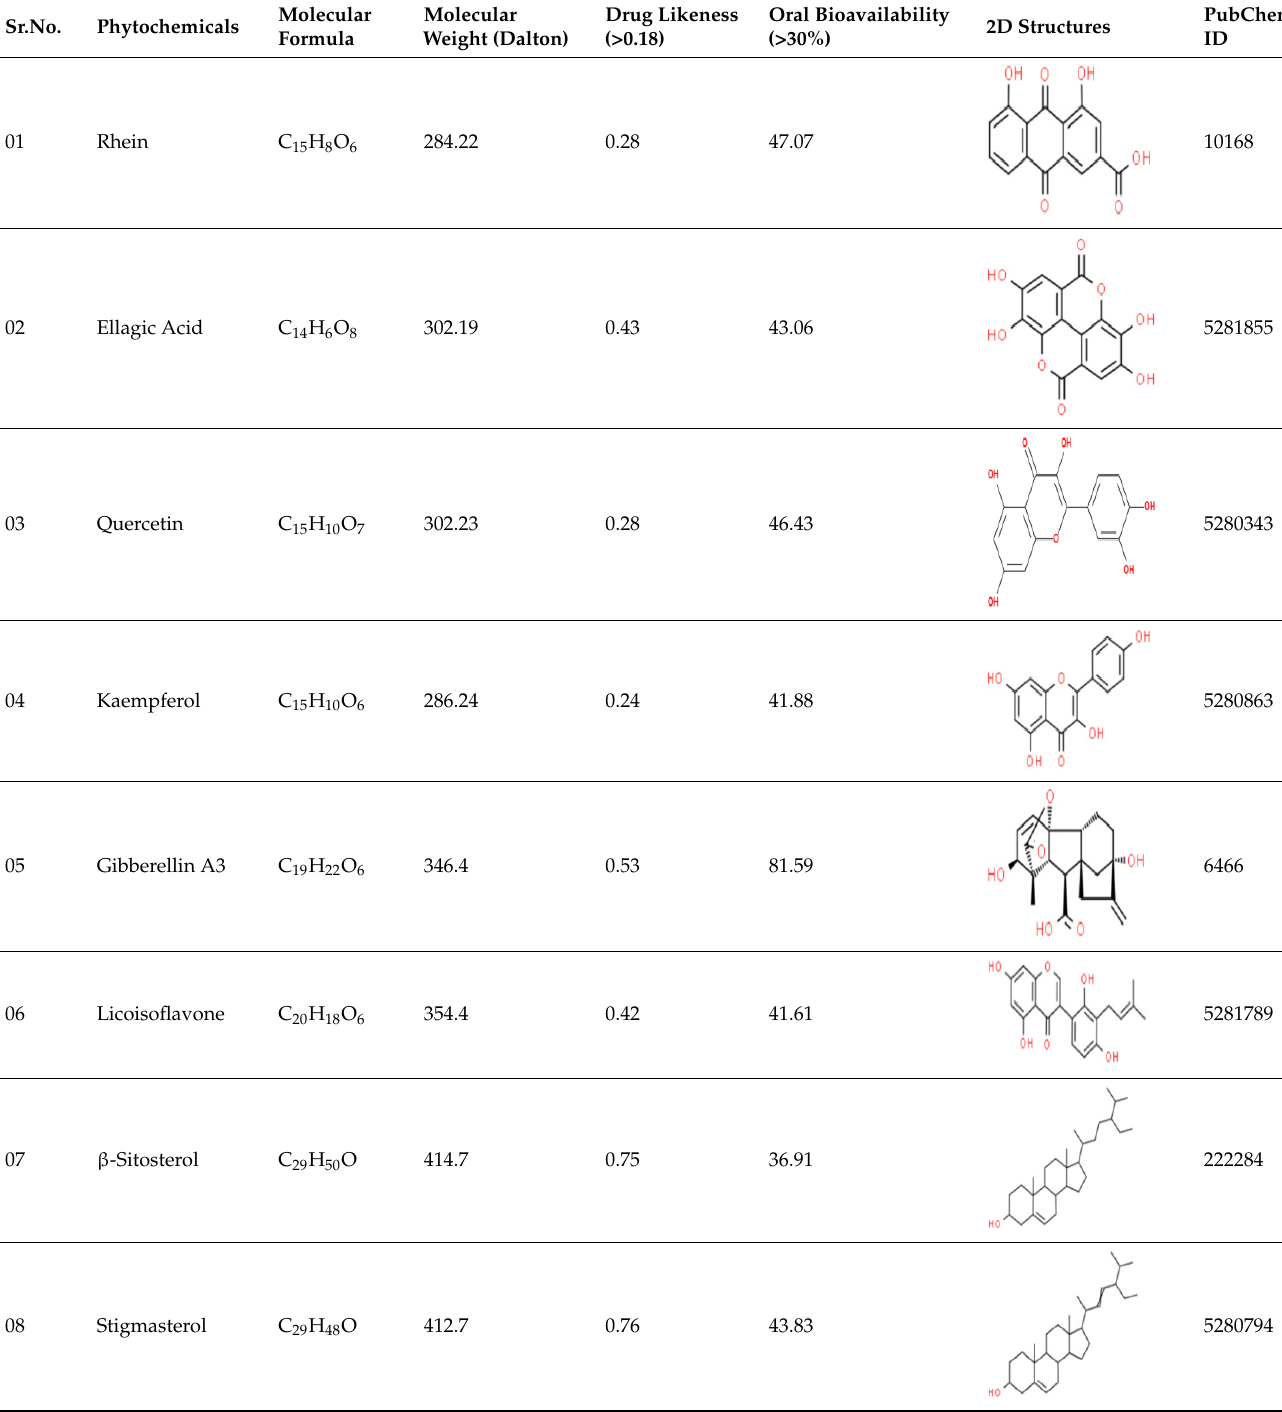
Table 1. Properties of active phytochemicals C. fistula .